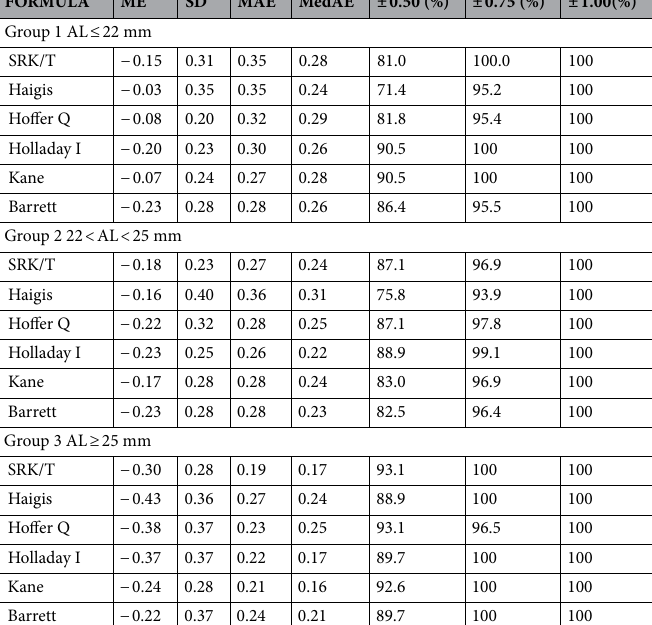
Table 2. Refractive prediction errors, SD, MAE, and MedAE. Percentage of Eyes Within Certain Range of Prediction Error. * p < 0.05 statistical significance.